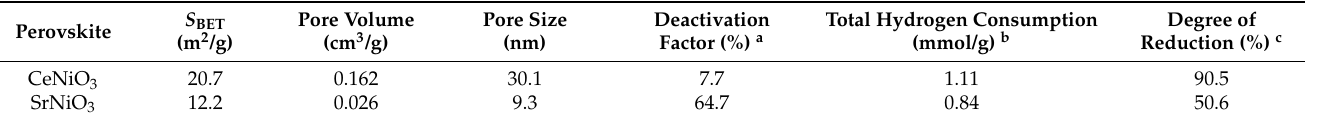
Table 2. Textural properties and deactivation factors of SrNiO 3 and CeNiO 3 perovskites. S BET Perovskite (m 2 /g)